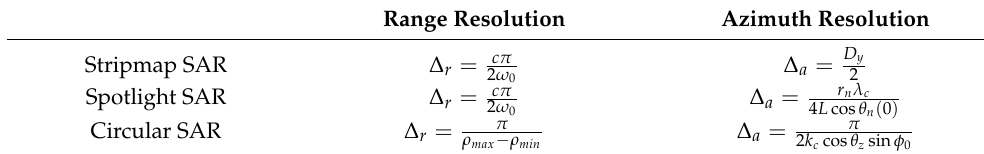
D y ∆ a = 2 r n λ c ∆ a = 4 L cos θ n ( 0 ) ∆ π a = 2 k c cos θ z sin φ